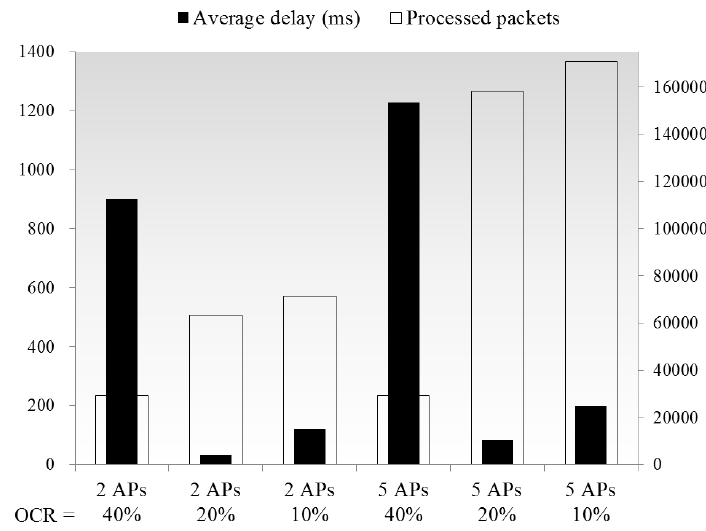
Figure 13. Comparison of averaged delay and number of processed packets in different OCR